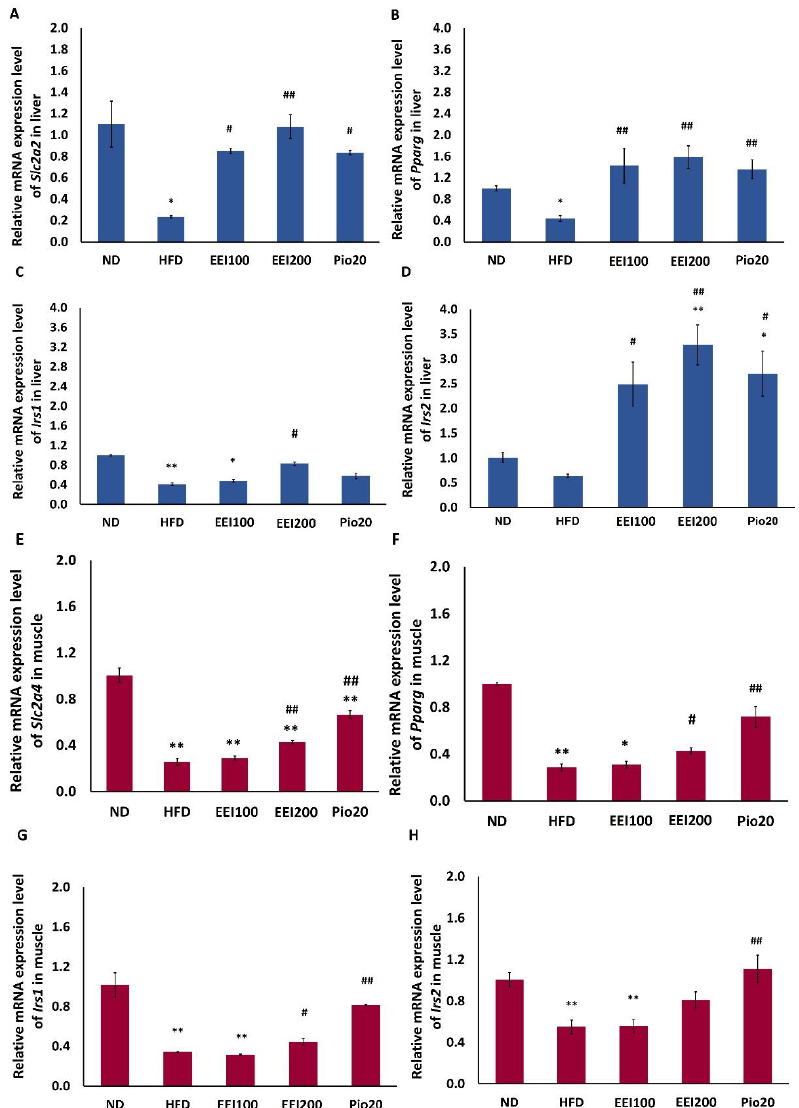
Figure 3. The effect of 2-week feeding EEI on gene expression of Slc2a2 ( A ), Pparg ( B ), Irs1 ( C ), Irs2 ( D ) in liver and Slc2a4 ( E ), Pparg ( F ), Irs1 ( G ), Irs2 ( H ) in soleus muscle tissues. Results are presented as the means ± SEM ( n = 10). Significant differences were presented as * p < 0.05 and ** p < 0.01 compared to the ND group, # p < 0.05 and ## p < 0.01 compared to the HFD group. ND = Normal diet- fed rats treated with vehicle; HFD = High fat diet-fed rats treated with vehicle; EEI100 = HFD-fed rats treated with 100 mg/kg/day of EEI; EEI200 = HFD-fed rats treated with 200 mg/kg/day of EEI; Pio = HFD-fed rats treated with 20 mg/kg/day of pioglitazone.